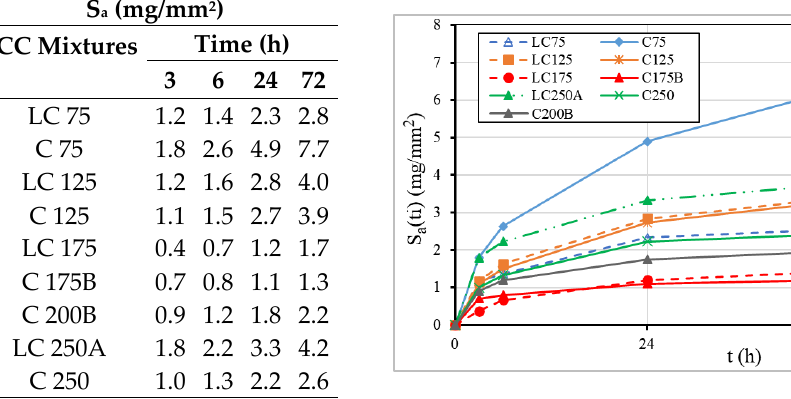
Figure 14. Average values of water absorption by capillarity at 3, 6, 24, and 72 h.